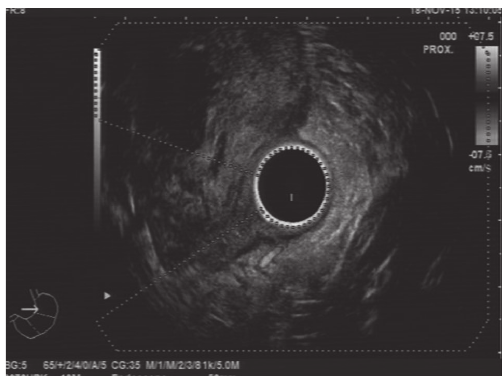
Figure 2: Submucosal swelling with erythematous surface extend- ing from the duodenal bulb to the 3rd part of the duodenum caus- ing partial duodenal obstruction: suspected intramural duodenal hematoma.